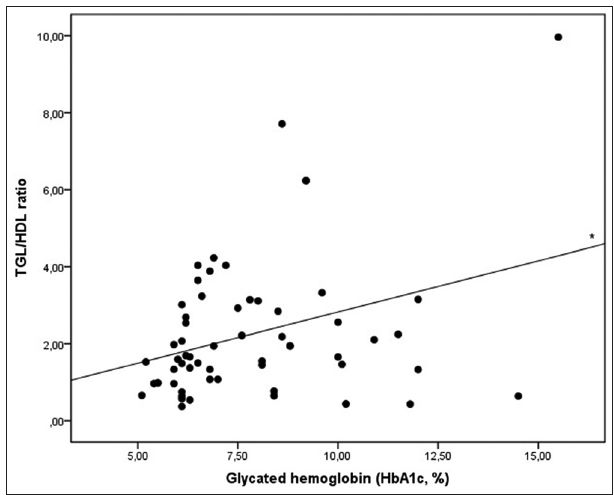
FIGURE 2. Correlation between concentrations of serum triglycerides and glycated hemoglobin (*ρ=0.298, p =0.021).